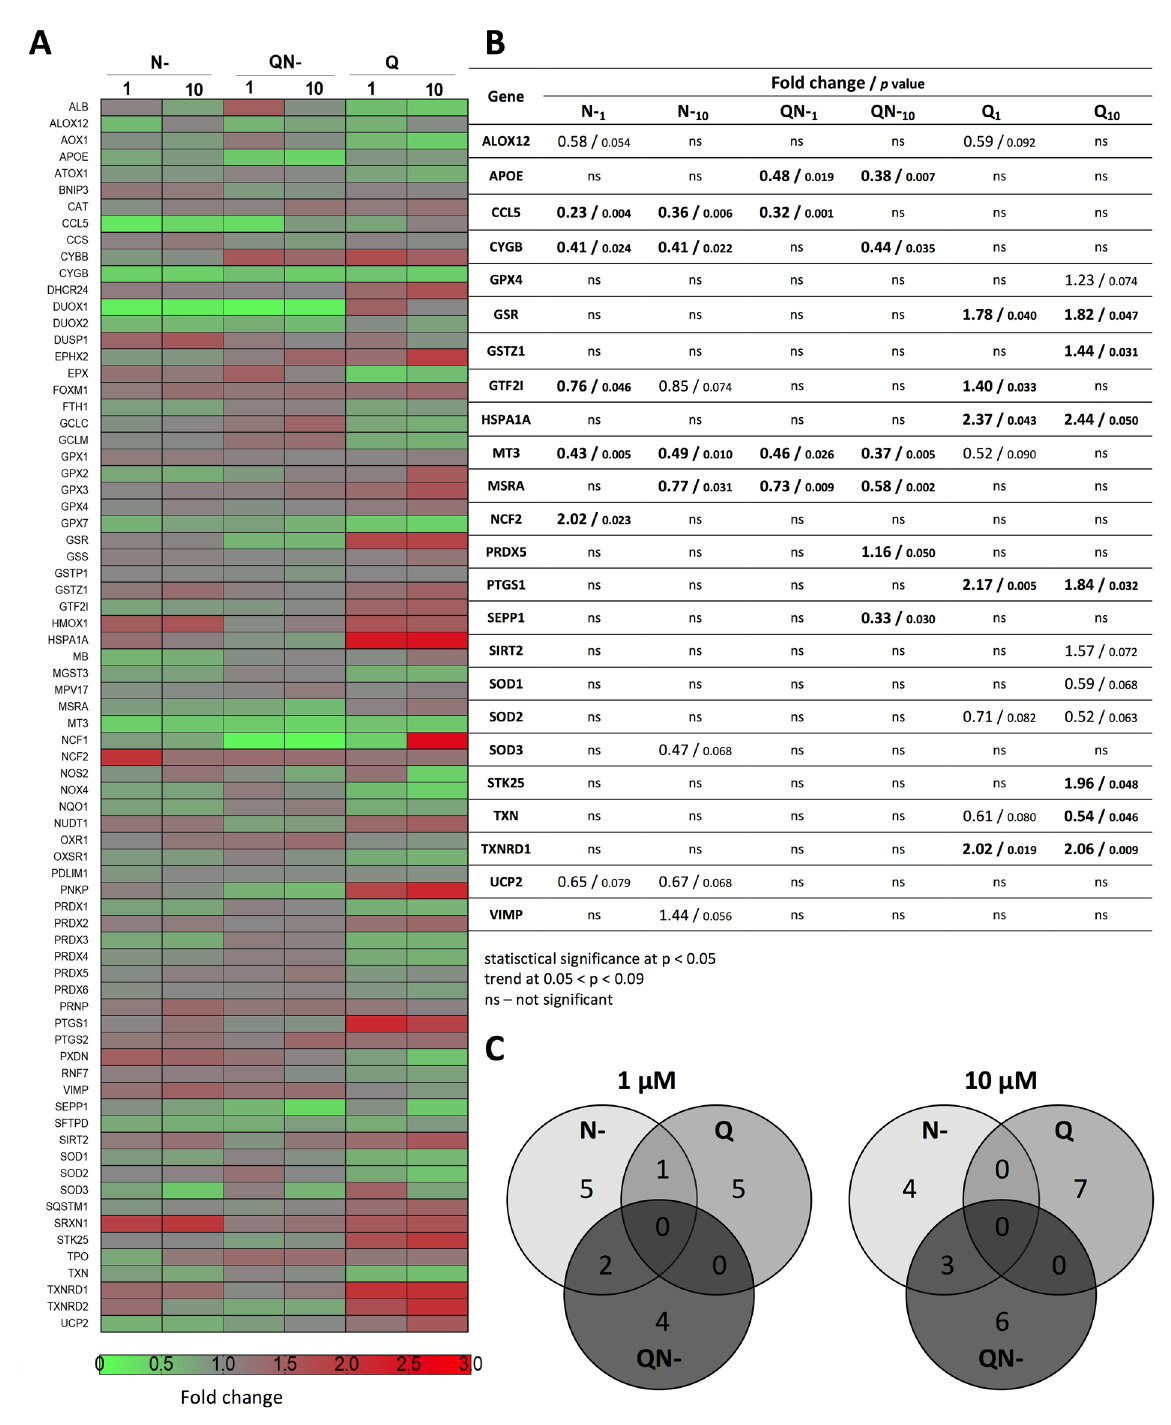
Figure 7. ( A ) heat map presenting the modulation of oxidative stress response and expression of antioxidant defence genes in HT29 cells after 24 h treatment with Q, N− at concentrations 1 or 10 μM and their mixture containing equal concentrations of each compound (1–10 μM). ( B ) Fold changes in the expression of genes as a result of treatment and probability values evaluated by the unpaired Student’s t-test. Statistically significant changes in the expression of genes are highlighted in boldface. ( C ) Venn diagram showing common genes regulated by Q, N− and QN− at p < 0.05. The results are calculated based on three independent